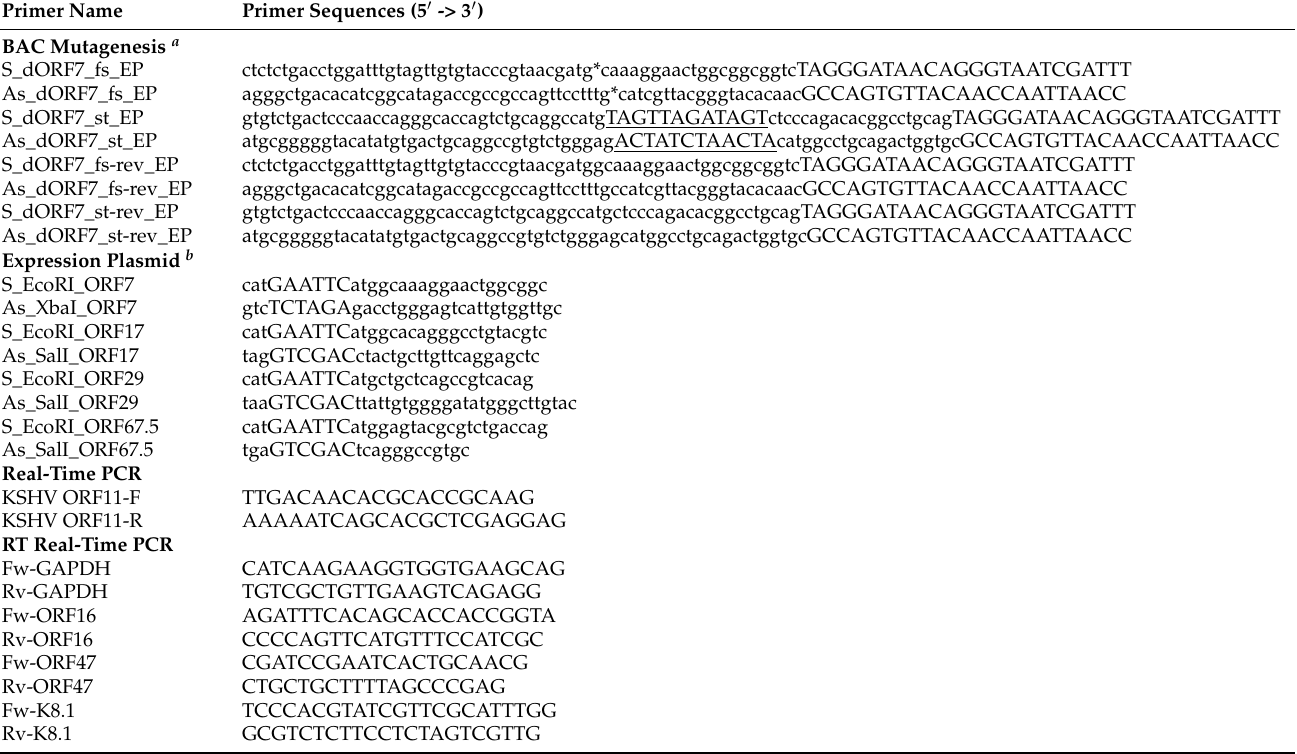
Table 2. Primers for BAC mutagenesis, construction of expression plasmids, real-time PCR, and RT real-time